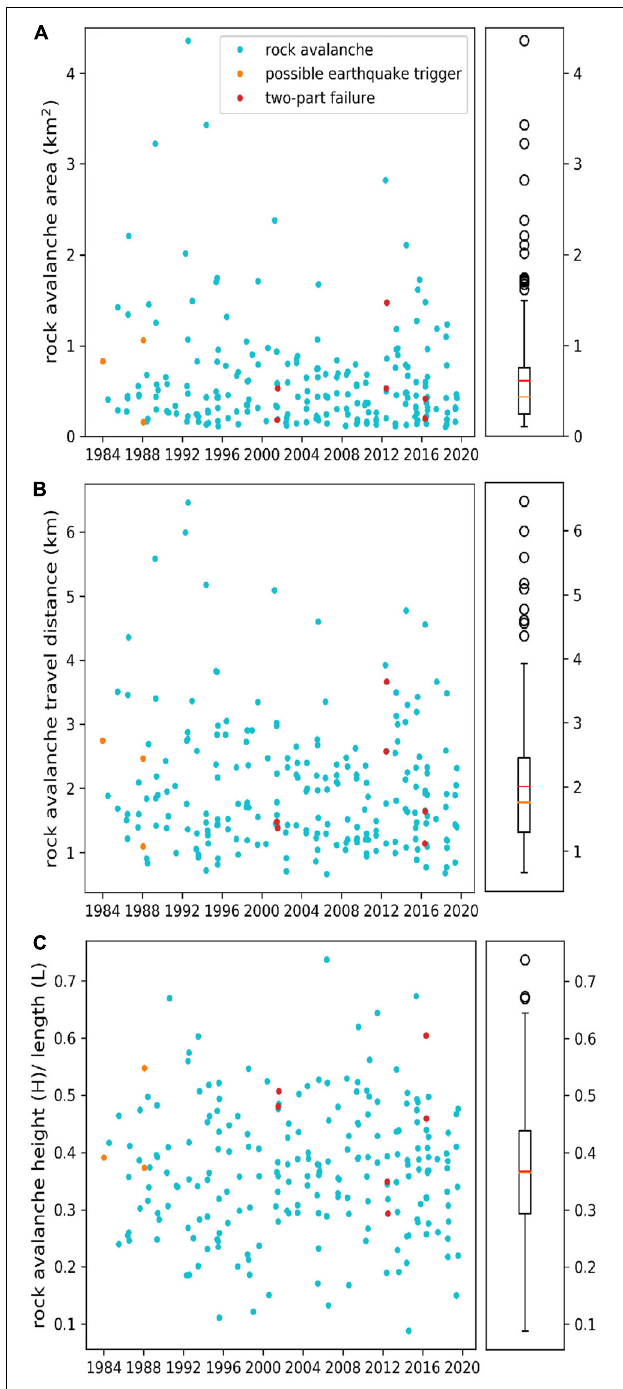
FIGURE 4 | Rock avalanche (A) area, (B) travel distance, and (C) ratio of fall height (H) to travel distance length (L) for rock avalanches in the Saint Elias study area during the period